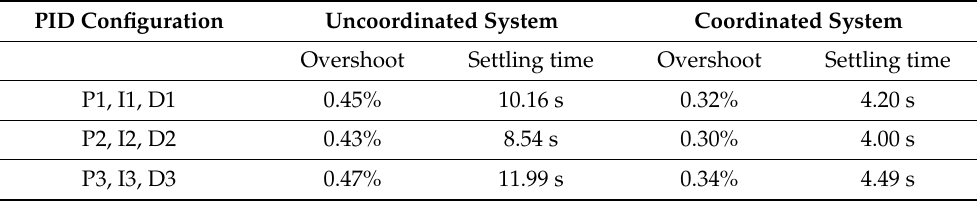
Table 6. Results of the sensitivity analysis on the parameters of the PID